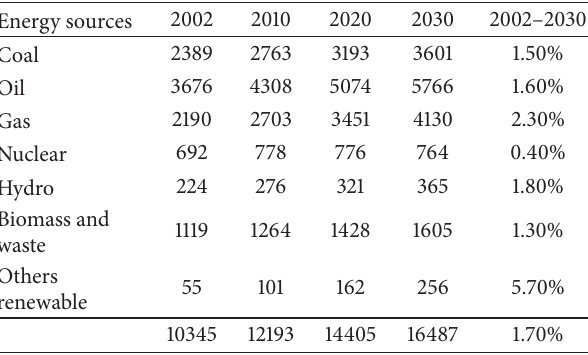
Table 2: World primary energy demand (Mtoe) [18].